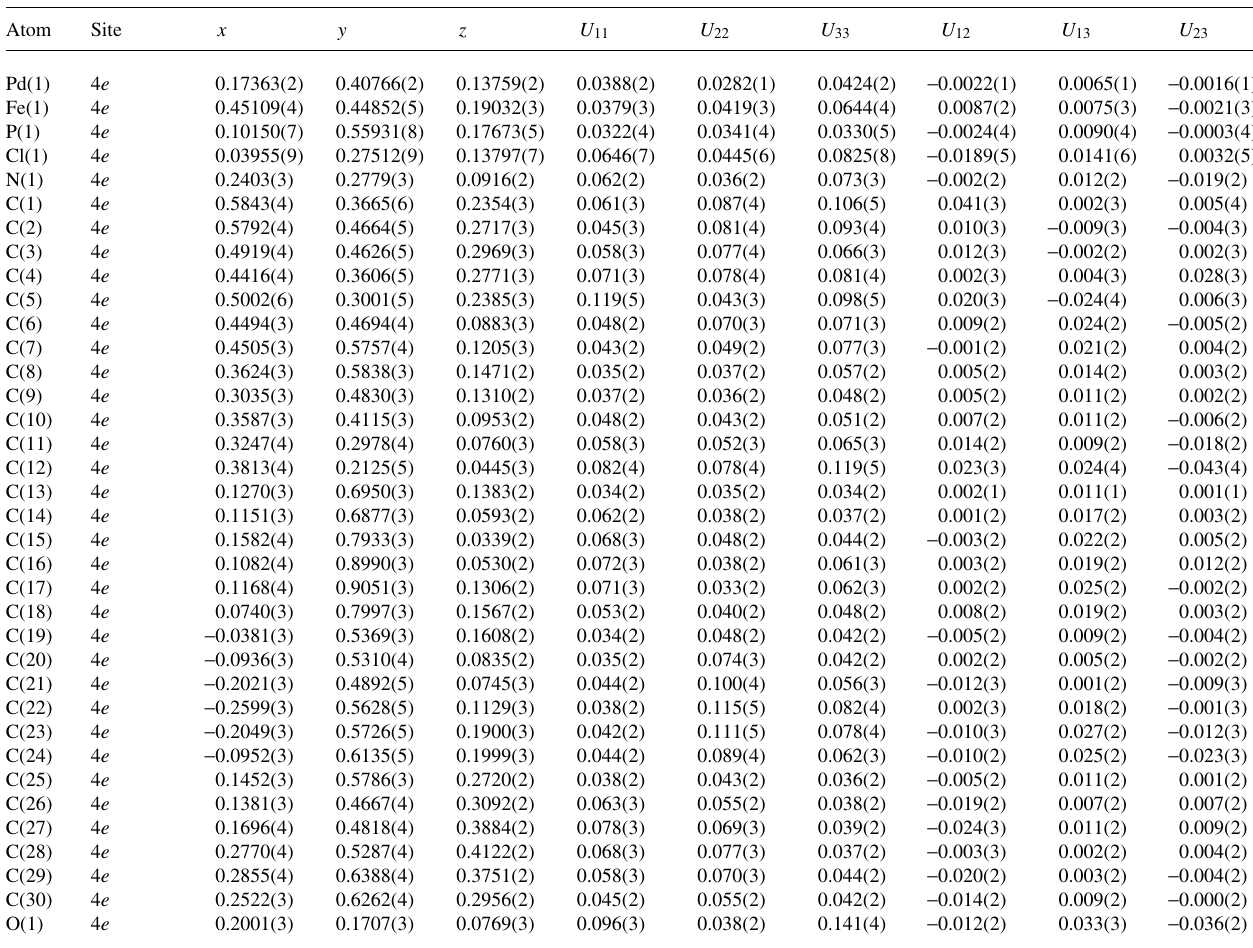
Table 3. Atomic coordinates and displacement parameters (in Å 2 )